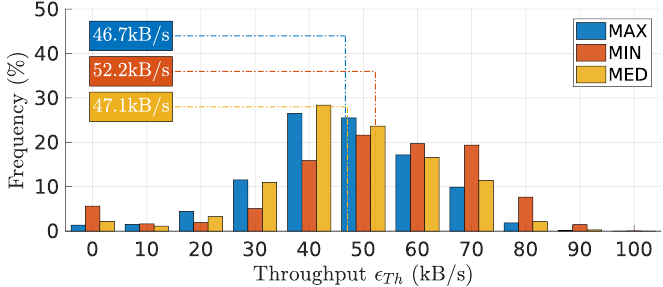
Figure 11. Distribution of the end-to-end throughput (cid:101) Th . MIN has the highest throughput (at 52.2 kB/s) due to the smallest effective period.